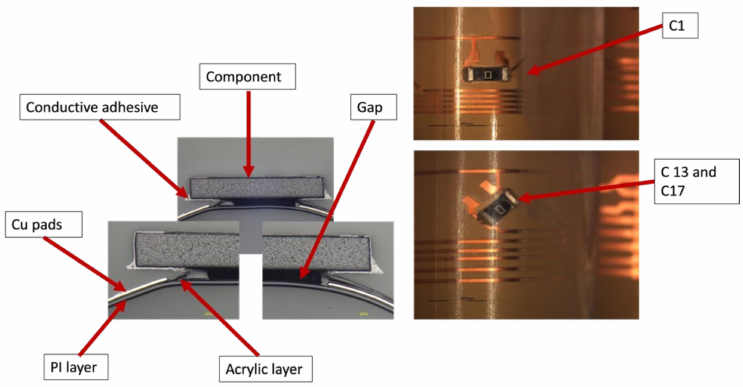
Figure 24. Cross-sectional images at 100 µ m for C1, C13, and C17 components ( Left ). Top view of the component at 3000 µ m ( Right